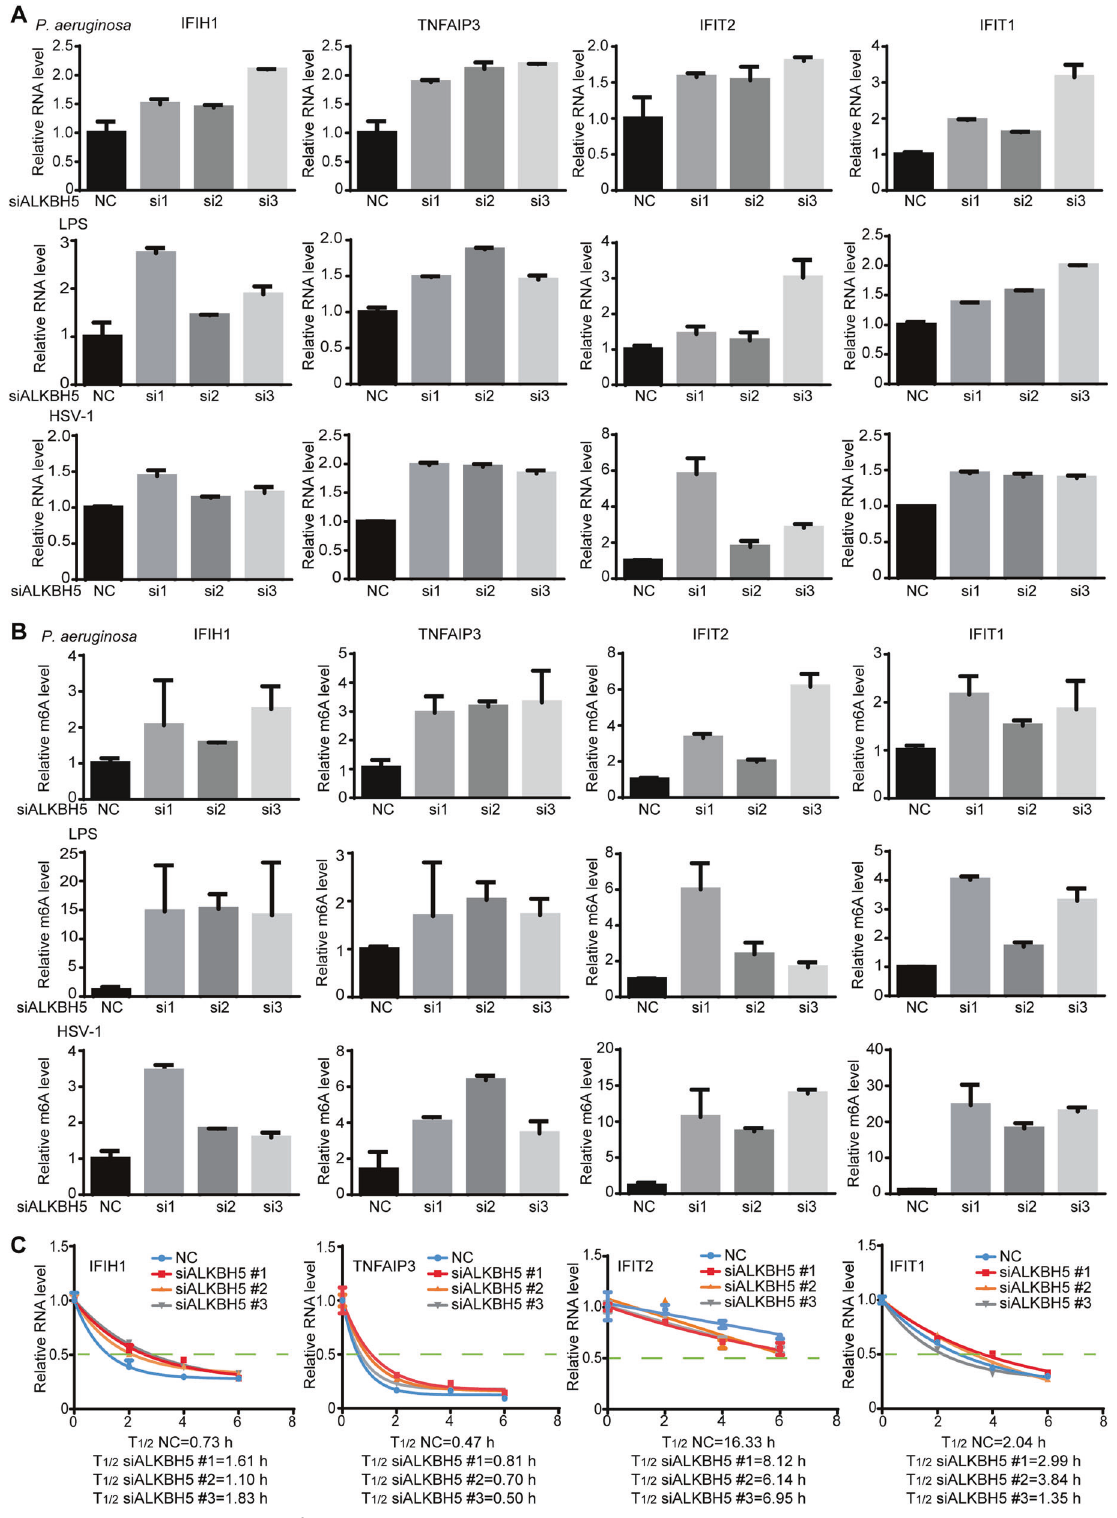
Fig. 6 Alterations of expression and m 6 A modi fi cation of innate immune response genes TNFAIP3, IFIH1, IFIT1 and IFIT2 during P. aeruginosa or HSV-1 infection, or LPS treatment following ALKBH5 knockdown. A Alterations of expression levels of TNFAIP3, IFIH1, IFIT1 and IFIT2 genes examined by RT-qPCR after infection with P. aeruginosa or HSV-1, or LPS treatment for 2 h following ALKBH5 knockdown. B Alterations of m 6 A levels of TNFAIP3, IFIH1, IFIT1 and IFIT2 genes examined by RT-qPCR after infection with P. aeruginosa or HSV-1, or LPS treatment for 2 h following ALKBH5 knockdown. C Alterations of half-lives of TNFAIP3, IFIH1, IFIT1 and IFIT2 transcripts during P. aeruginosa infection following ALKBH5 knockdown. RAW264.7 cells with ALKBH5 knockdown were infected with P. aeruginosa or HSV-1, or treated with LPS for 2 h, in the presence of 10 μ g/mL actinomycin D, and collected for RT-qPCR at the indicated time points.